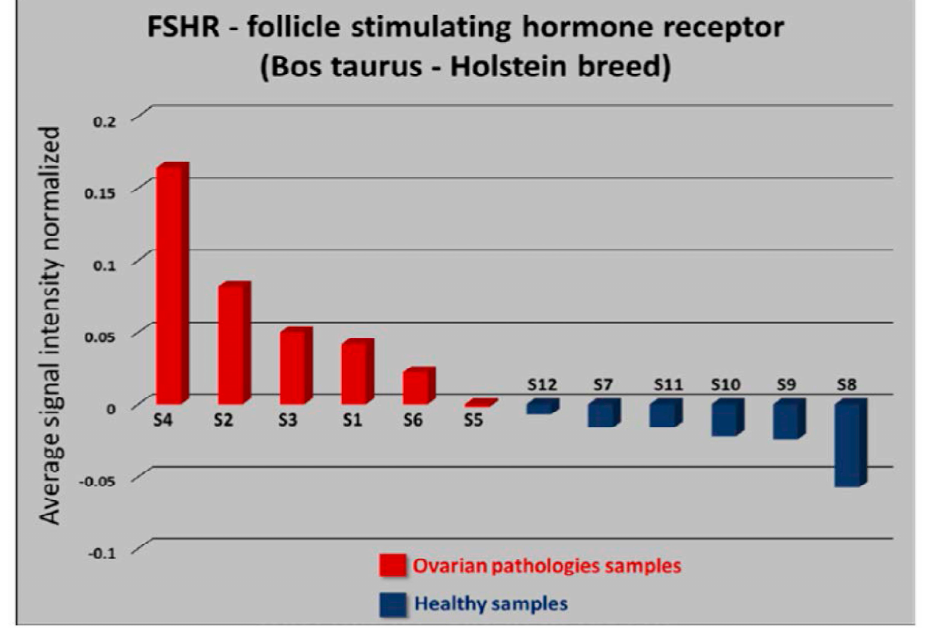
Figure 2. Principal component analysis for Follicle stimulating hormone receptor. The plot shows PC1 sorted average loading values of normalized signal intensity for every sample.